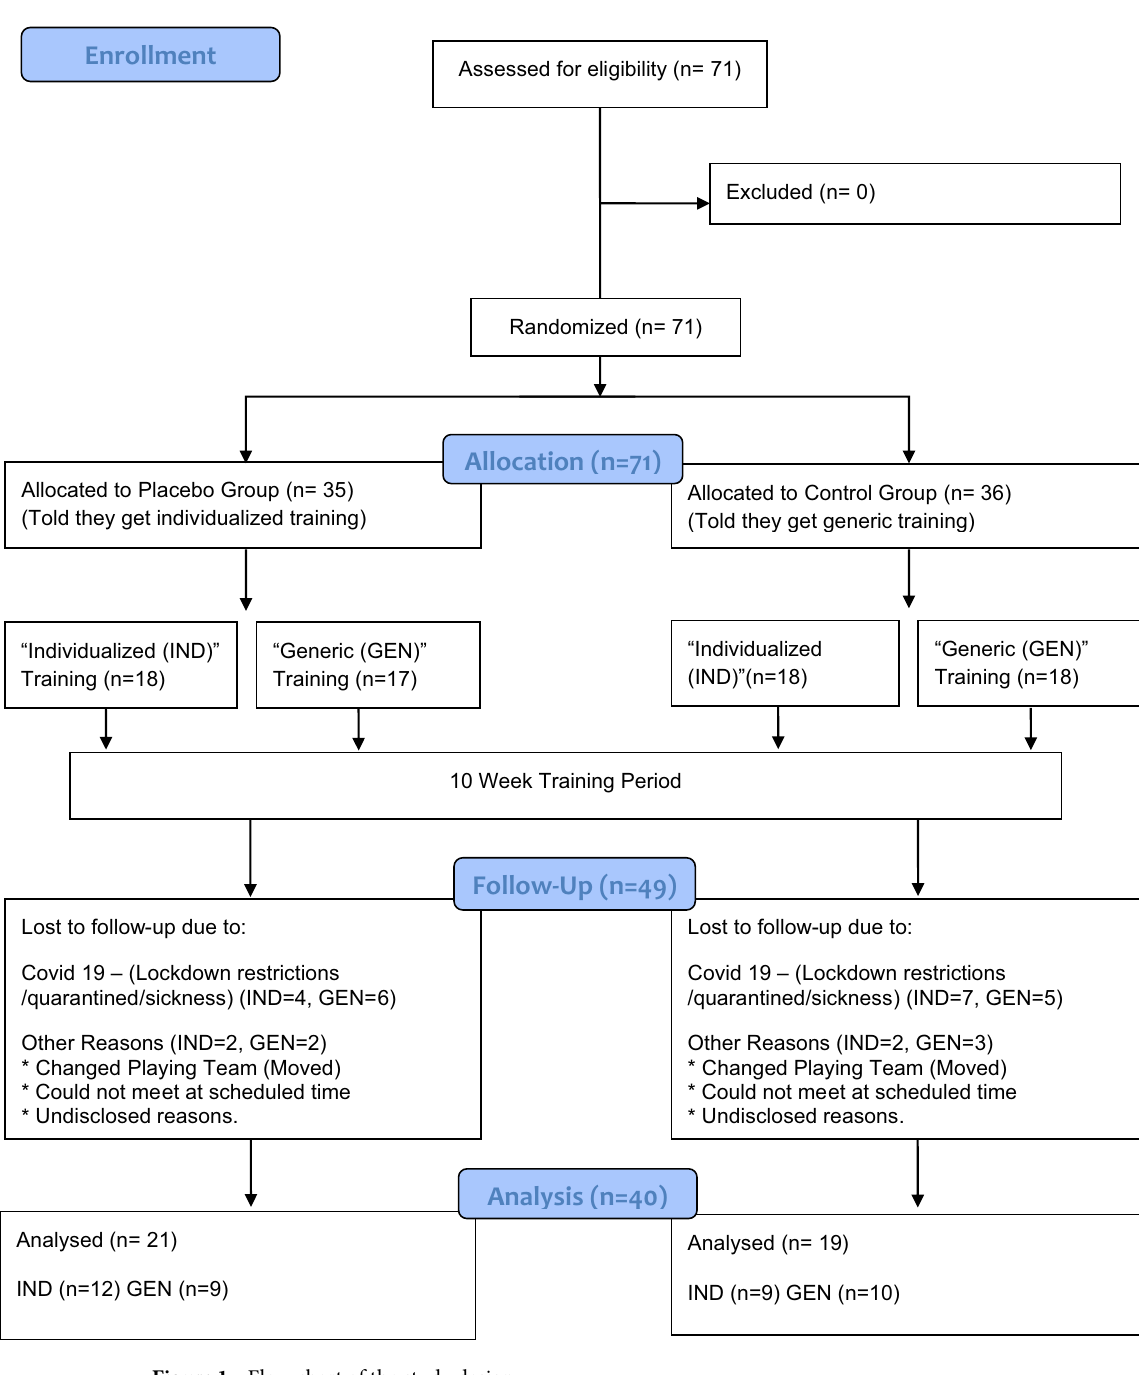
Figure 1. Flow chart of the study